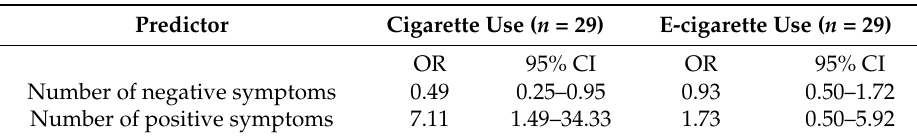
Table 4. Associations between symptoms during first use and current tobacco